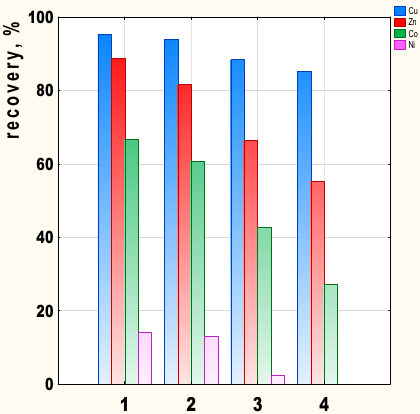
Figure 6. Transport recovery of Cu(II), Zn(II), Co(II), and Ni(II) ions after 24 h depending on the carrier used; 2-methylimidazole ( 1 ), 2-ethylimidazole ( 2 ), 2-propylimidazole ( 3 ), and 2-butylimidazole ( 4 ). Metal recovery depends on the carrier used in the membrane, with the highest recovery values achieved in the case of 2-methyl- ( 1 ) and 2-ethylimidazole ( 2 ) (Figure 6). Cu(II) recovery is the highest, ranging from 95.5 (membrane 1 ) to 85.4% (membrane 4 ) depending on the membrane used. Zn(II) and Co(II) recovery clearly decrease for carriers 3 and 4 . There is little transport of Ni(II) ions across all the membranes tested, hence the